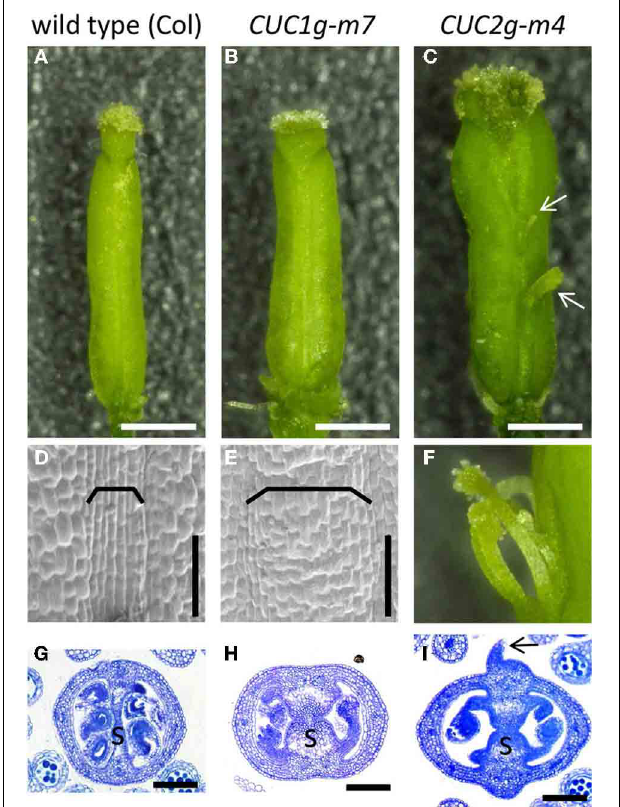
FIGURE 5 | Gynoecium phenotype of CUC1g-m7 and CUC2g-m4 . Mature gynoecia of wild type Col (A,D,G) , CUC1g-m7 (B,E,H), and CUC2g-m4 (C,F,I) . Whole view (A–C) , scanning electron micrograph of replum (D,E) , close up view of filamentous structures (F) and transverse sections of ovary (G–I) . Arrows in (C,I) indicate filamentous structures. Brackets indicate repla. s, septum. Scale bars are: (A–C) , 500 µ m; (D,E,G–I) , 100 µ